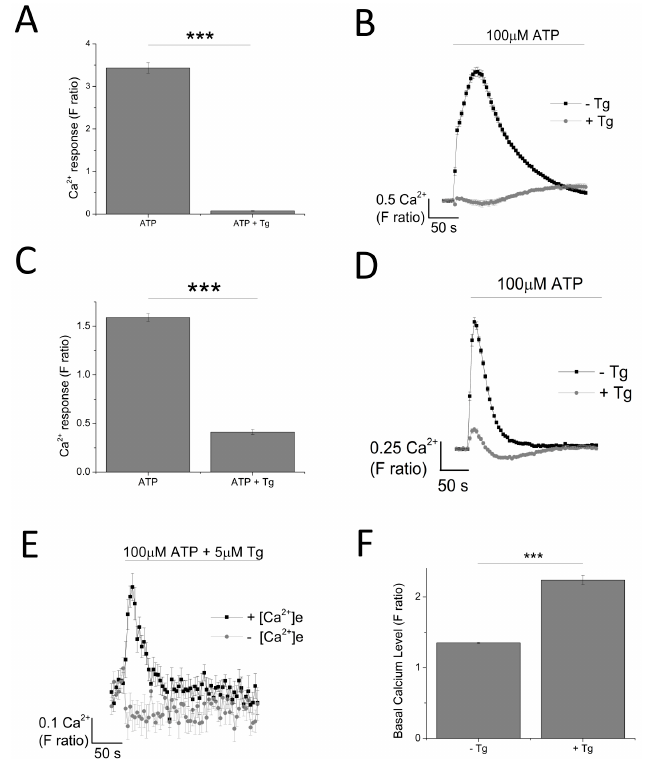
Figure 3. Dependency of ATP-evoked Ca 2+ response on the endoplasmic reticulum Ca 2+ store. The effect of 100 μ M ATP in the presence and absence of 5 μ M Tg in: ( A , B ) THP-1 monocytes ( n = 3) and ( C , D ) THP-1 differentiated macrophages ( n = 6); ( E ) time-response curve of the effect of Tg on 100 μ M ATP in the presence and absence of extracellular Ca 2+ ( n = 6); ( F ) effect of 5 μ M Tg on basal Ca 2+ level in THP-1 differentiated macrophages ( n = 6). Asterisks include significant changes towards control (*** p < 0.001).